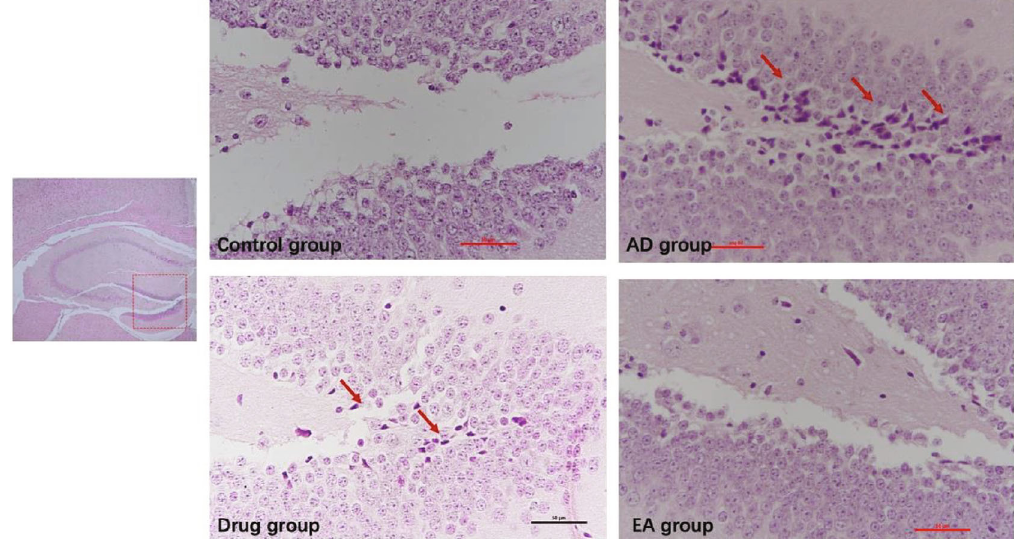
Figure 2: Results of HE staining in each group (3 samples of each group). In this study, we focused on the dentate gyrus zone in the hippocampus, the zone that was most related with learning and memory abilities. The red arrows point at the most neurons that lost their function in the AD group; compared with the AD group, the EA group observed less neuron apoptosis in the